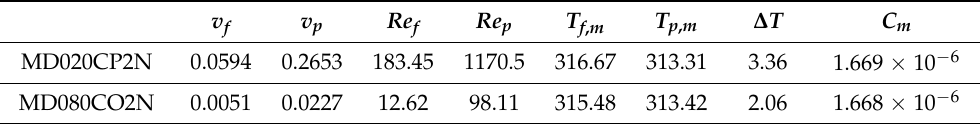
Figure 8. Transmembrane fluxes of MD020CP2N and MD080CO2N modules for the same membrane thickness (0.05 mm) and different number of fibers (40 and 467). Table 6. Transmembrane fluxes for different number of fibers.